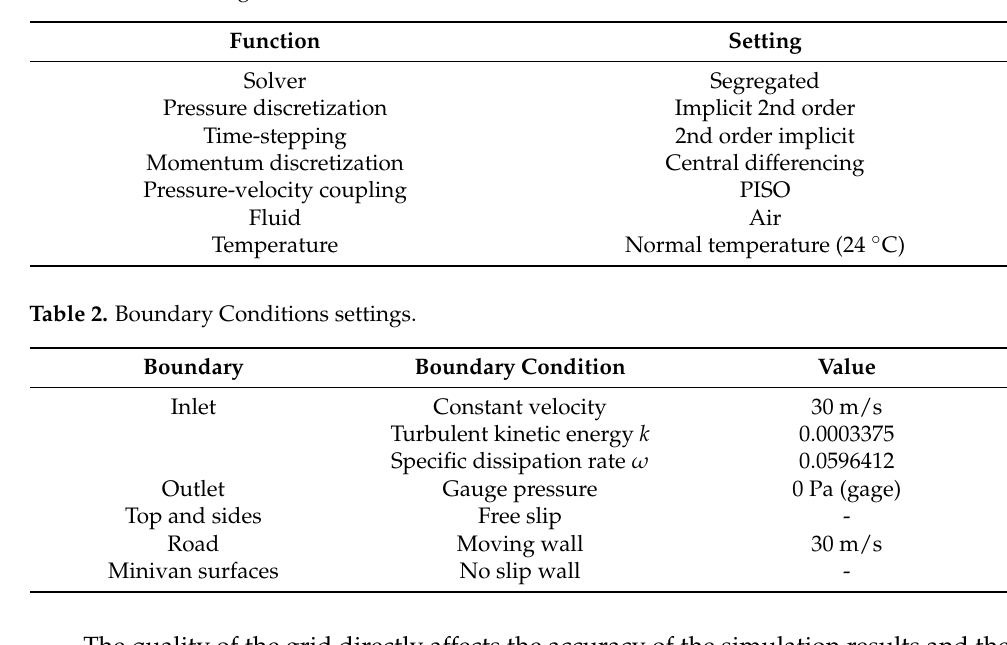
Table 1. Solver settings.